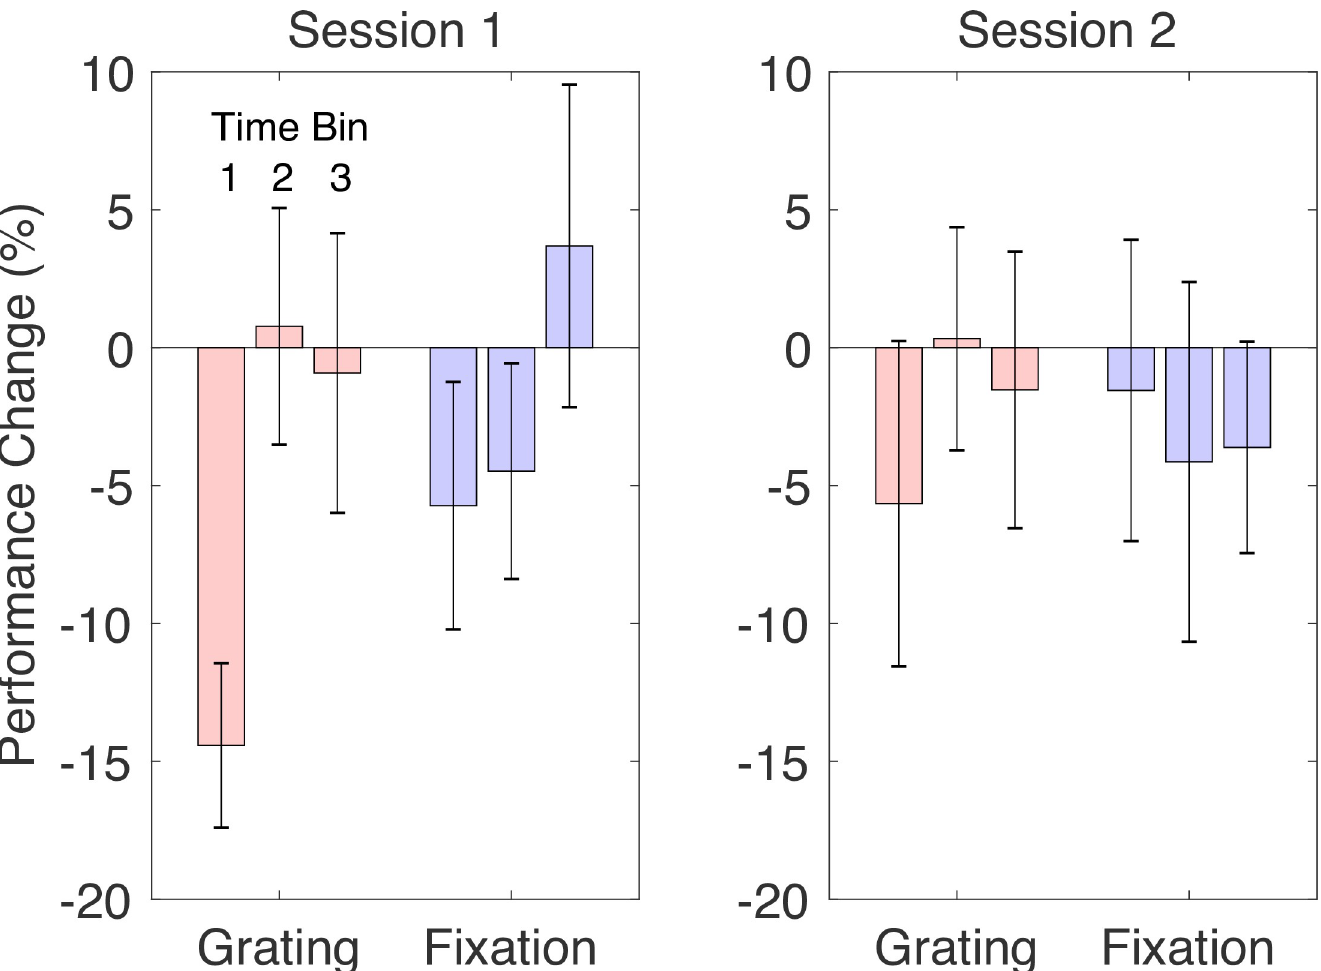
Fig 10. Pooled secondary task performance. Mean change in performance between baseline and adaptation conditions for the Grating Task and the Fixation Task is shown, pooled across both experiments. Other plotting conventions are as in Fig 9.